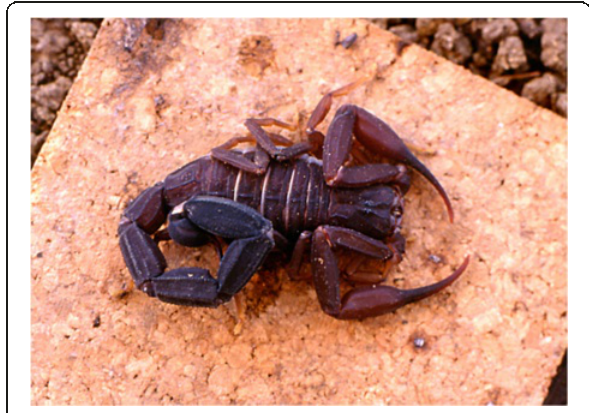
Fig. 21 Tityus ( Atreus ) insignis (Pocock, 1889); male from the island of Saint Lucia